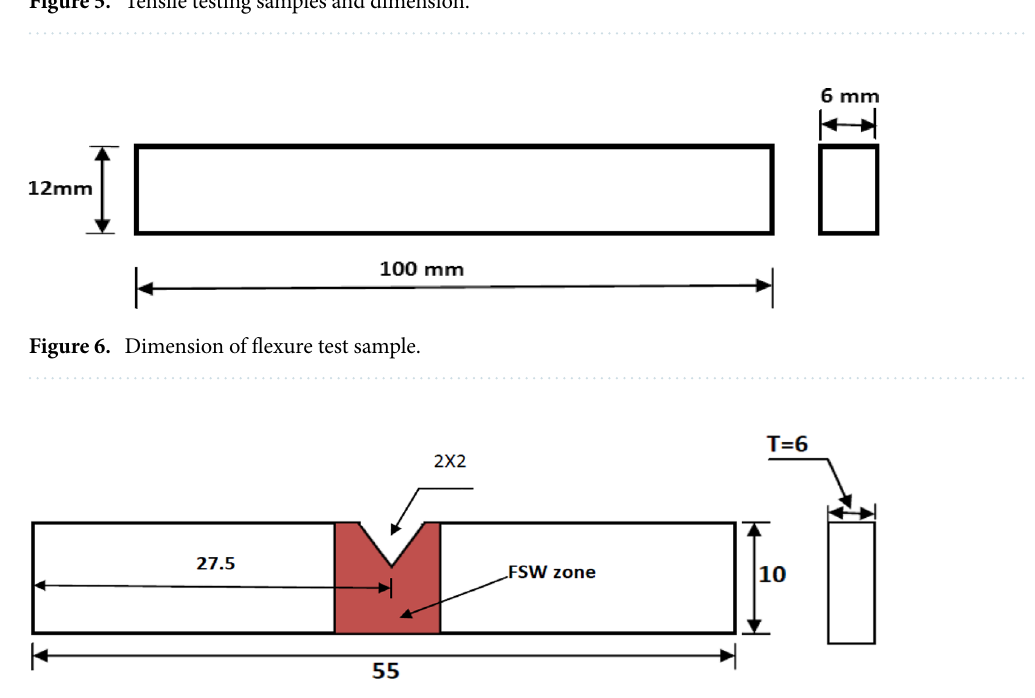
Figure 7. Dimension of impact test sample.